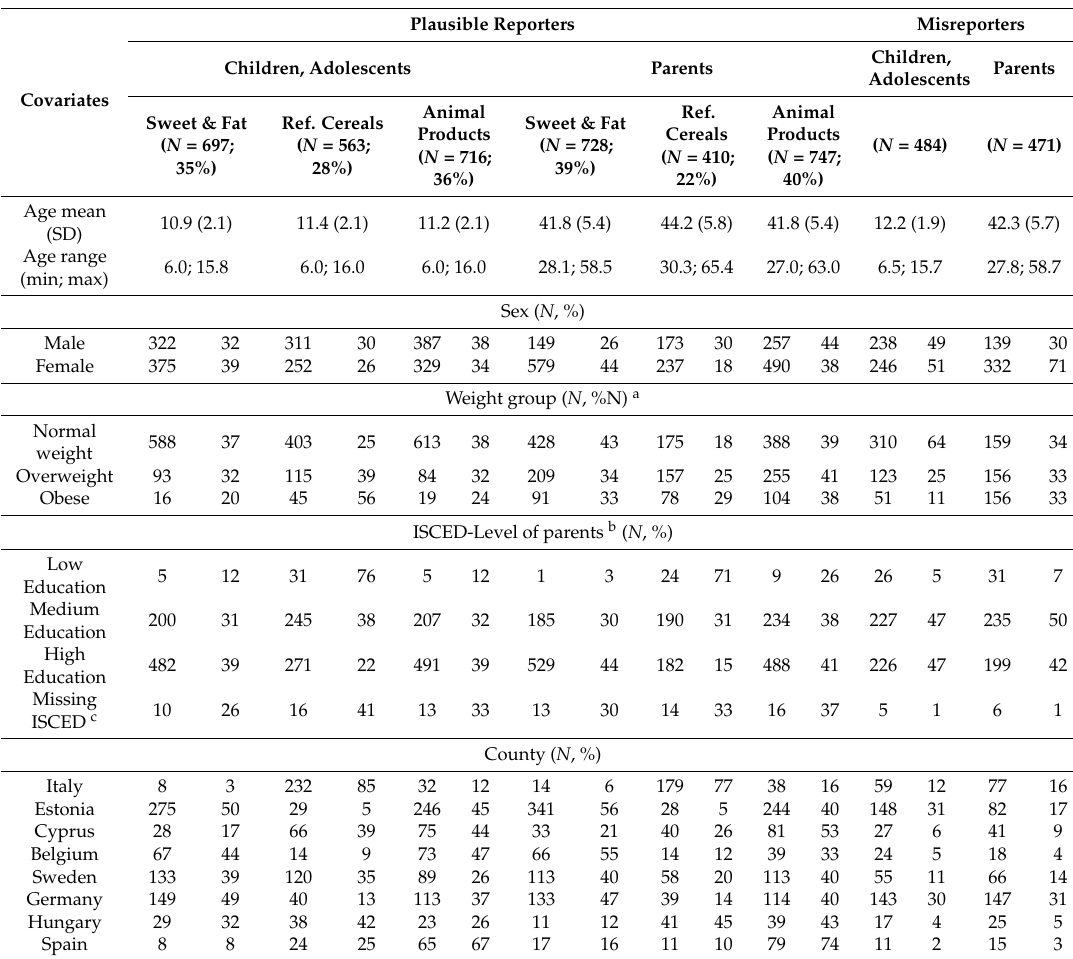
Table 3. Characteristics of the study population, including plausible reporters stratified by cluster membership and misreporters (number and